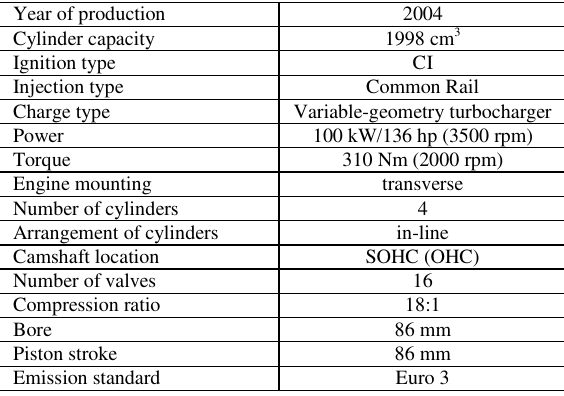
Fig. 1. Research engine 2.0 MZR-CD Table 1. 2.0 MZR-CD basic technical parameters